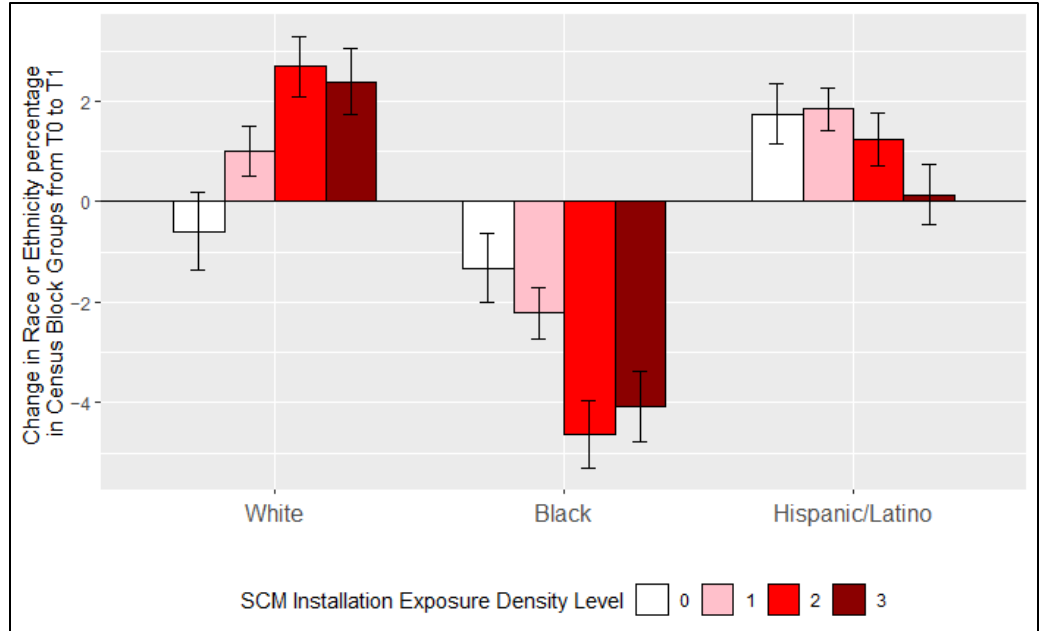
Figure 2. Change in percent of residents who are White, Black, and Hispanic/Latino in Census block groups from the 5-year interval before stormwater control measure (SCM) installation (T0) to the 5-year interval after SCM installation (T1) with varying levels of SCM installation exposure density. Error bars represent the 95% confidence